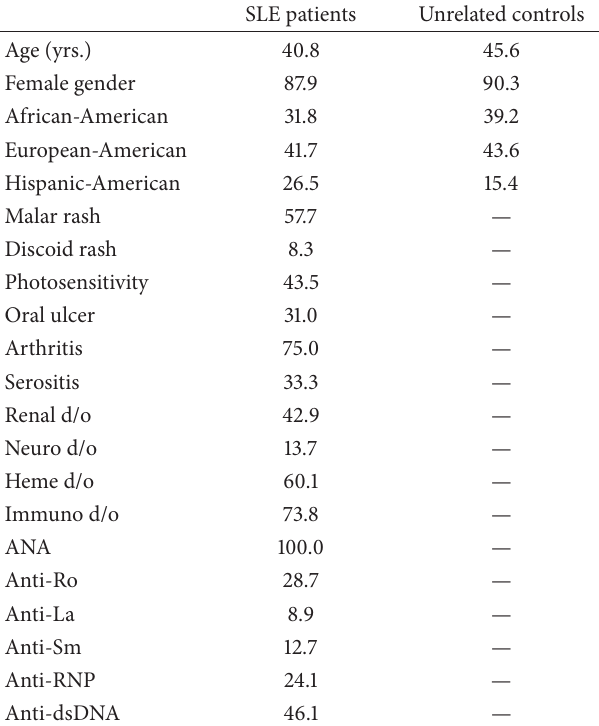
SLE patients Unrelated